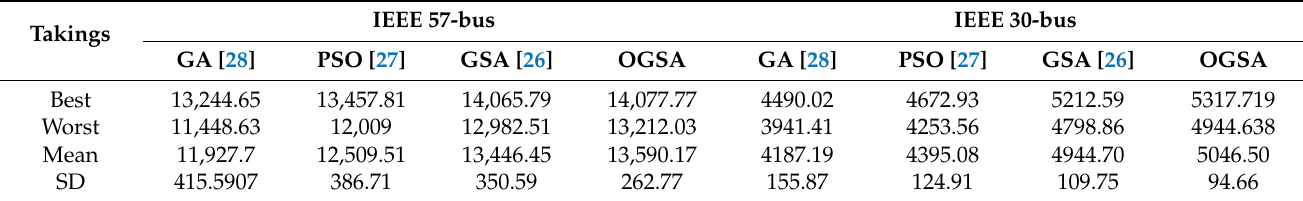
Table 6. Relative analysis of a variety of methods for checking the strength of OGSA.